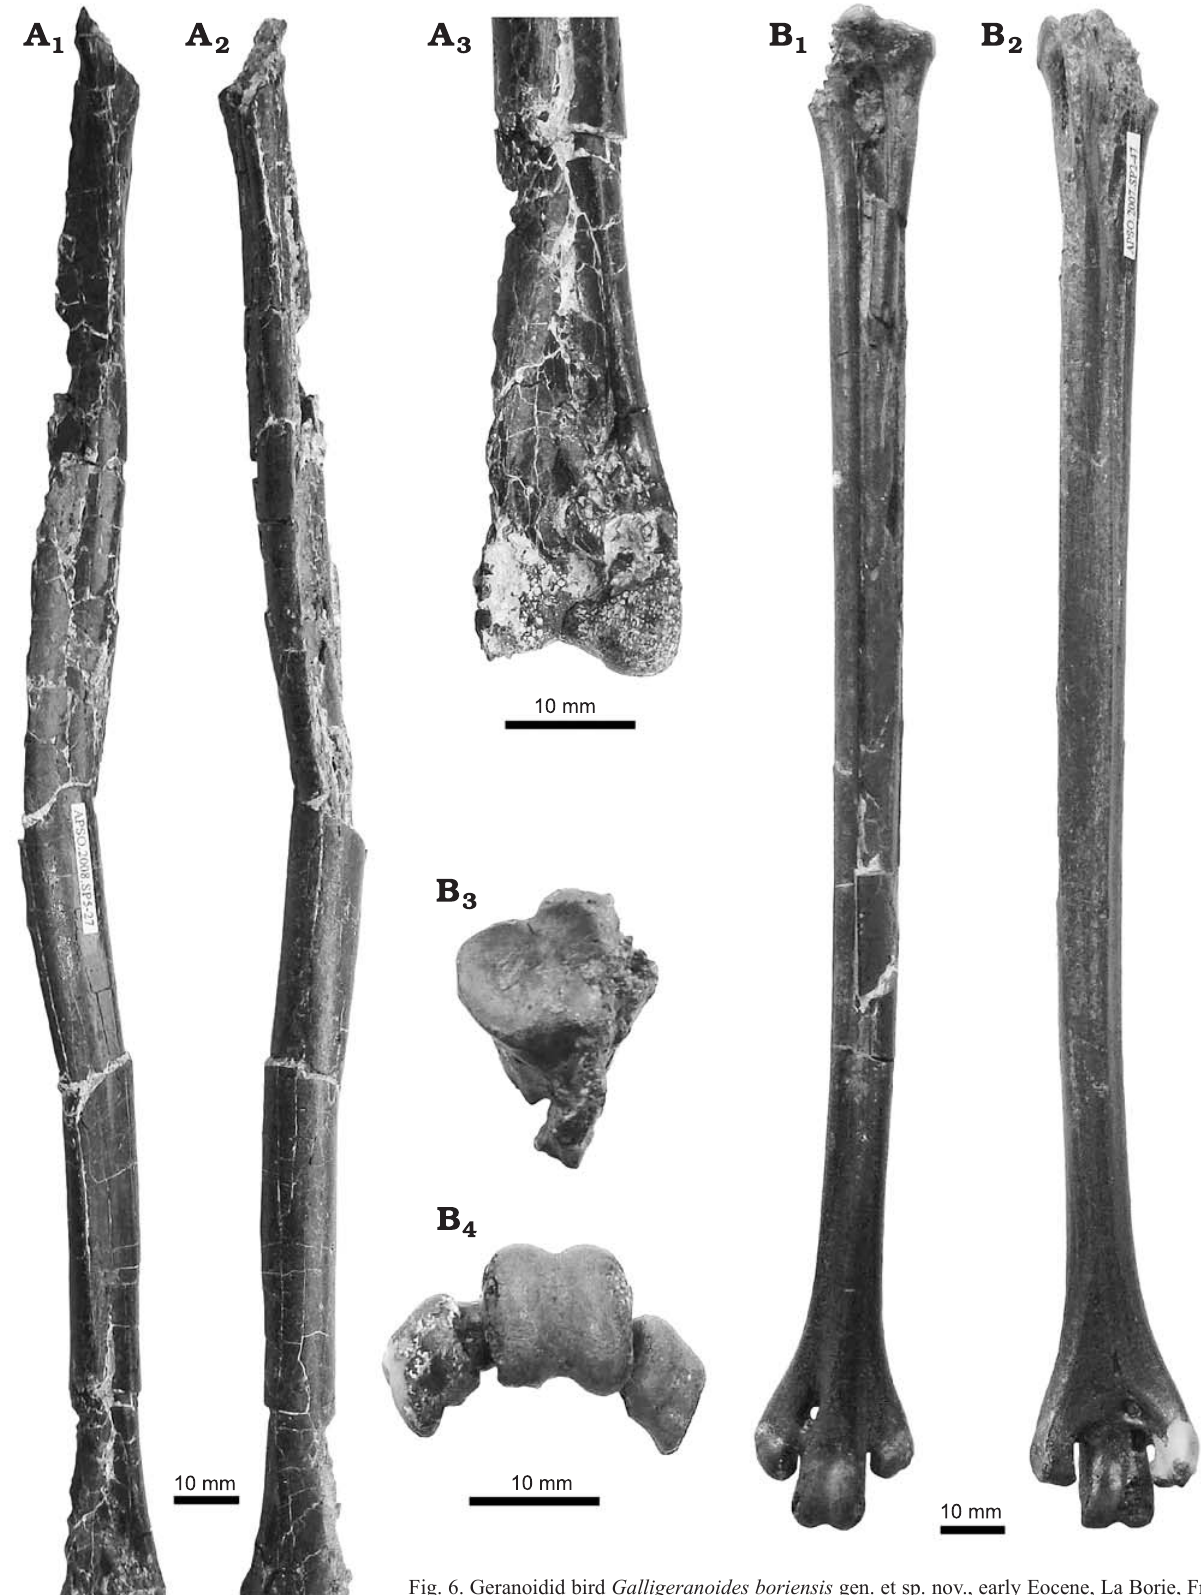
Fig. 6. Geranoidid bird Galligeranoides boriensis gen. et sp. nov., early Eocene, La Borie, France. A . Right tibiotarsus MHNT.PAL.2013.16.1 (paratype), in cranial (A ) and caudal (A ) views and 1 2 distal part in cranial view (A ). B . Right tarsometatarsus MHNT.PAL.2013.16.2 (paratype), in cra- 3 nial (B ), plantar (B ), proximal (B ), and distal (B ) 1 2 3 4